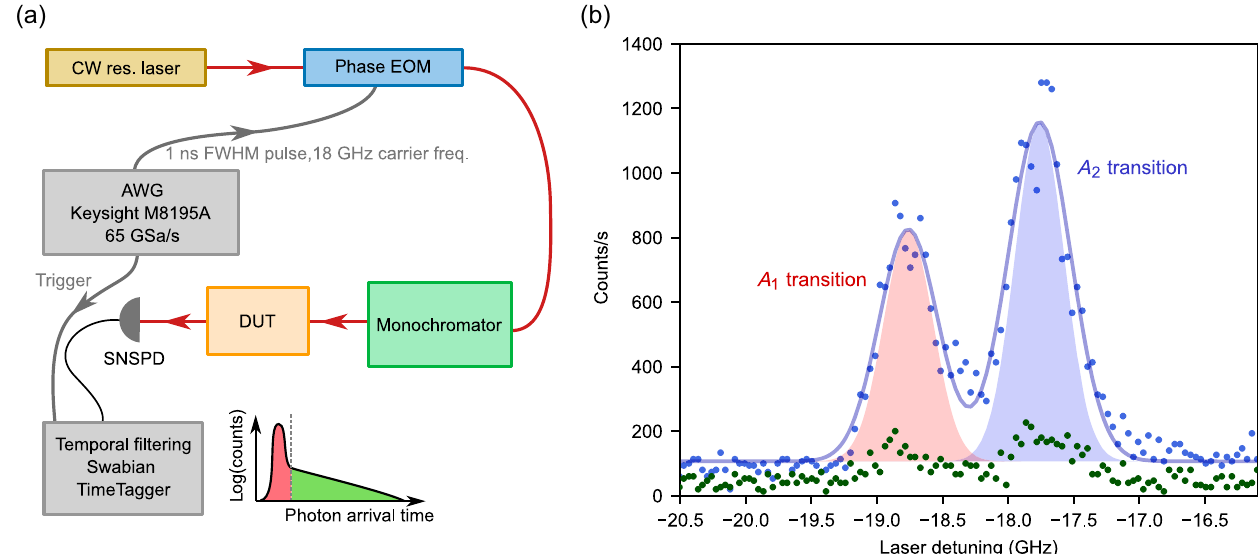
FIG. 11. Spin-selective temporally filtered resonance fluorescence. (a) Diagram of the experimental configuration. Temporally modulated laser sideband at 18 GHz is generated using a phase electro-optic modulator (EOM) driven by an arbitrary signal generator (AWG). The sideband is spectrally filtered and sent to the device. The detected photons ’ arrival times are correlated with the excitation pulse (Swabian Time Tagger): The earlier photon arrivals corresponding to the excitation pulse are discarded. (b) Resonance fluorescence spectrum of a single V (blue data points) taken with 1 ns FWHM excitation pulses. The shaded areas correspond to the Si excitation pulse transform limit (0.44 GHz FWHM). The green data points are the simultaneously acquired phonon sideband emission. Because of the strong Purcell enhancement of the defect, the phonon sideband detection rate is significantly lower than that of the